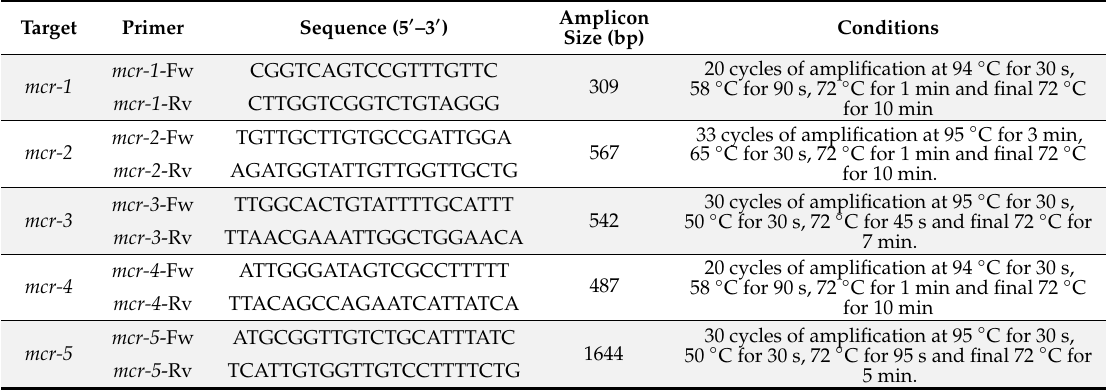
Table 2. Primers and conditions used for the amplification of the mcr